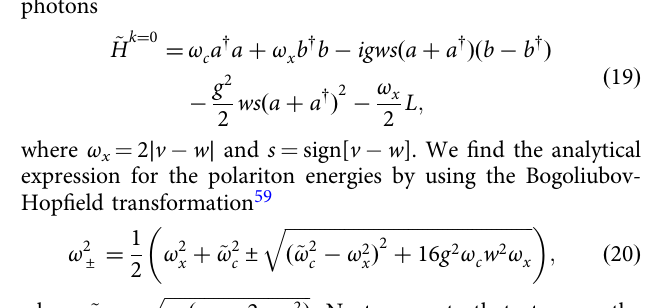
ffiffiffiffiffiffiffiffiffiffiffiffiffiffiffiffiffiffiffiffiffiffiffiffiffiffiffiffiffiffi p ω ð ω (cid:2) 2 wsg 2 Þ c c